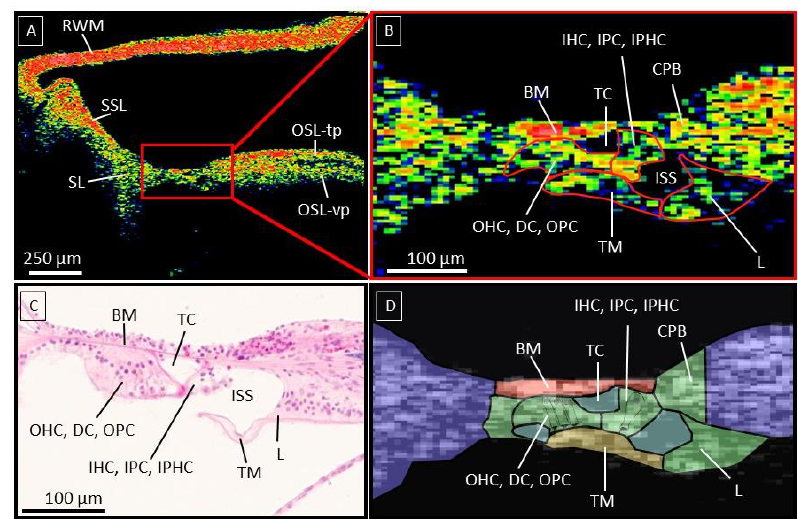
Figure 2. ( A ): illustrates an OCT cross-section (a-scan rate 10 kHz) of a fresh human temporal bone in color scale, with high scattering tissue in red. ( B ): is a zoomed-in cross-section of the OoC, with the cell groups indicated based on important landmarks such as the ISS, TM, and TC. ( C ): Histological section as validation for the OoC anatomy. ( D ): Schematic overview of the recognizable structures within the OoC. Abbreviations; Basilar membrane (BM), tunnel of Corti (TC), inner hair cells (IHC), outer hair cells (OHC), inner spiral sulcus (ISS), Tectorial membrane (TM), Spiral Limbus (L), Reticular Lamina (RL), Osseous Spiral Lamina tympanic plate (OSL-tp), OSL vestibular plate (OSL-vp), Reissner’s membrane (RM), Spiral Ligament (SL), Secondary Spiral Lamina (SSL), Round window membrane (RWM). Figure 2C was used with the written permission of the Massachusetts Eye and Ear otopathology temporal bone atlas.